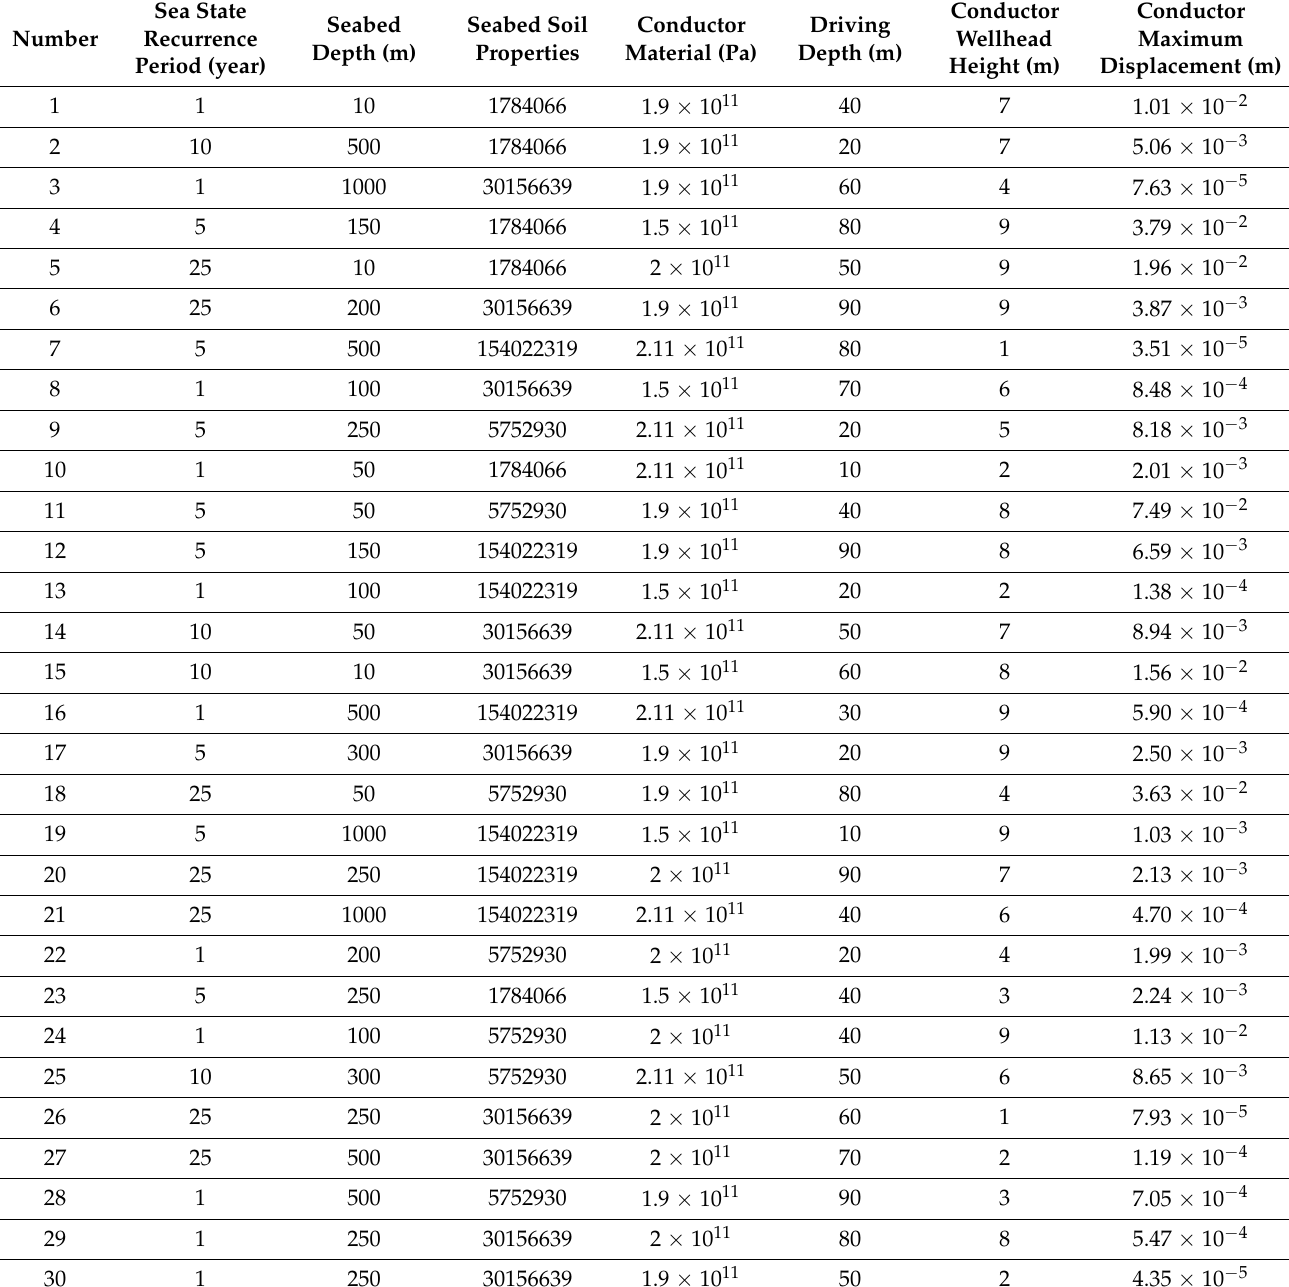
Table A1. Input data of weight analysis based on